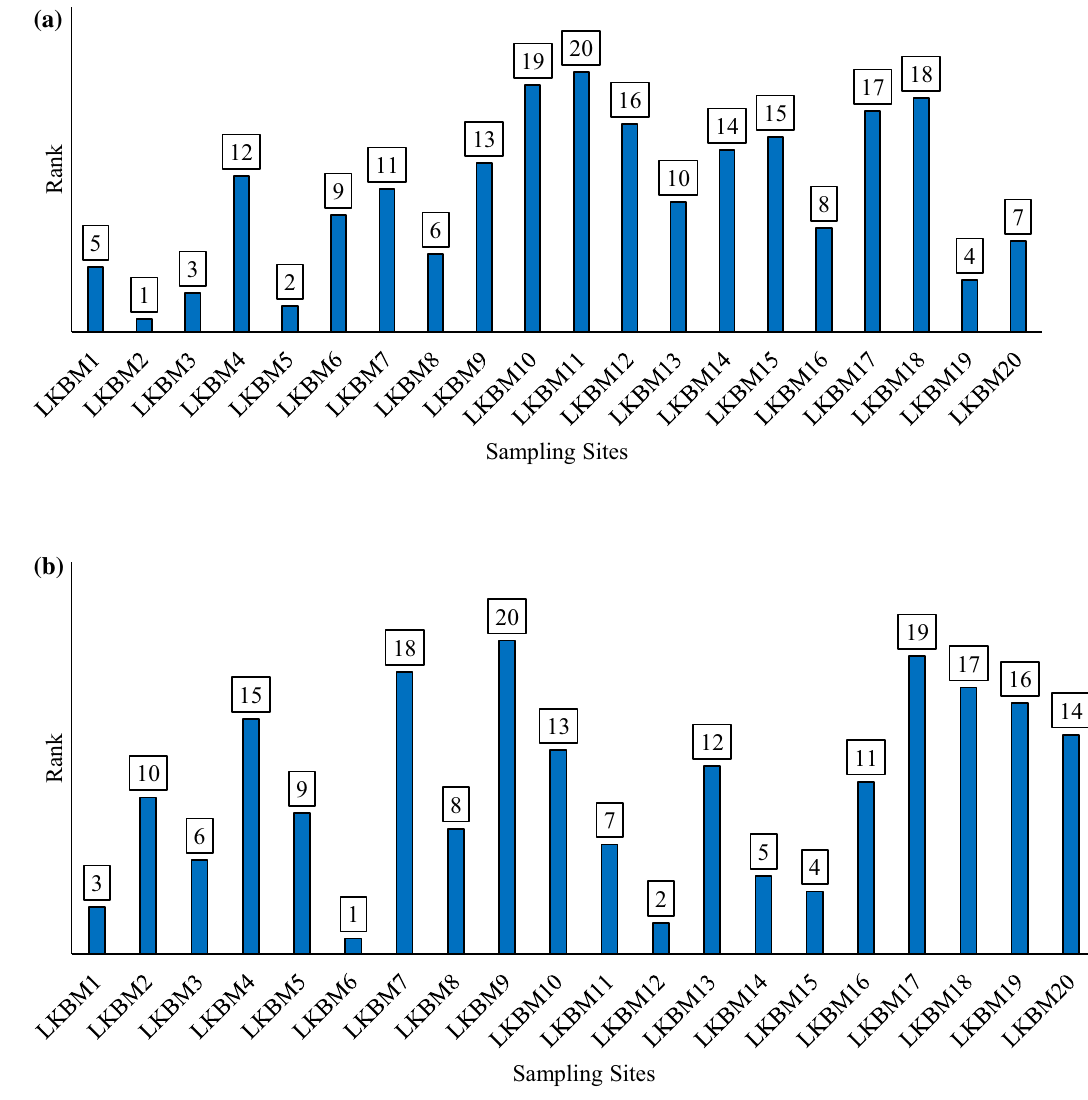
Fig. 2 a Pre-monsoon rank of sampling site. b Post-monsoon rank of sampling